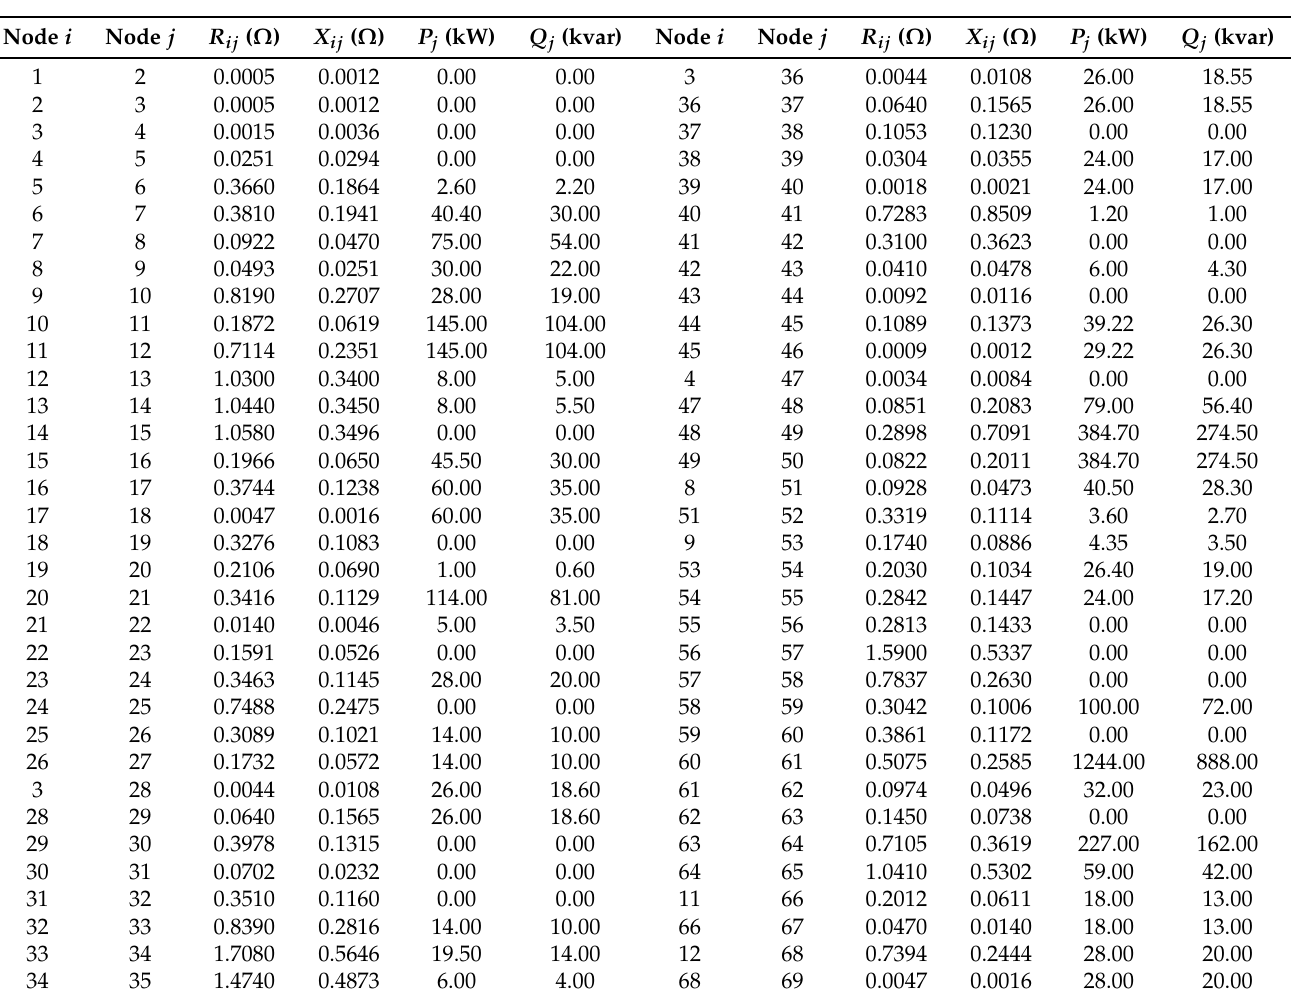
Table 5. Branch and load parameters for the IEEE 69-bus system.